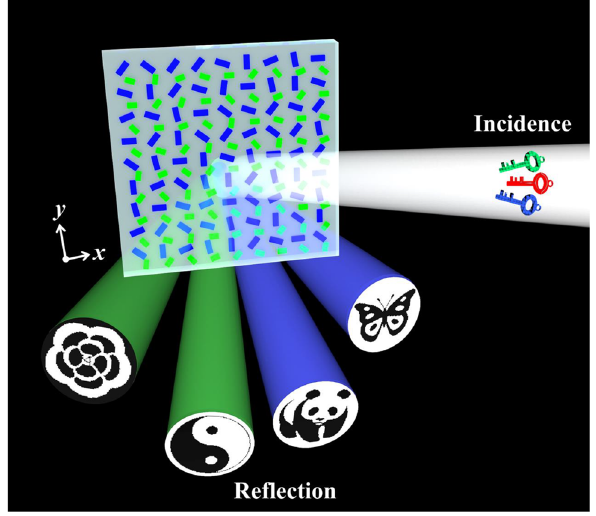
Figure 1: Schematic of four-channel display metasurface, which can separately store four distinguishable nanoprinting images and display them in the near-field reflection by specific security keys for independent channels. The metasurface is composed of two kinds of Ag nanorods with different orientations on a glass substrate. A normally incident linearly-polarized beam is used to display the hidden information encoded in the metasurface with optical parameters (amplitude, polarization, and wavelength) as specific security